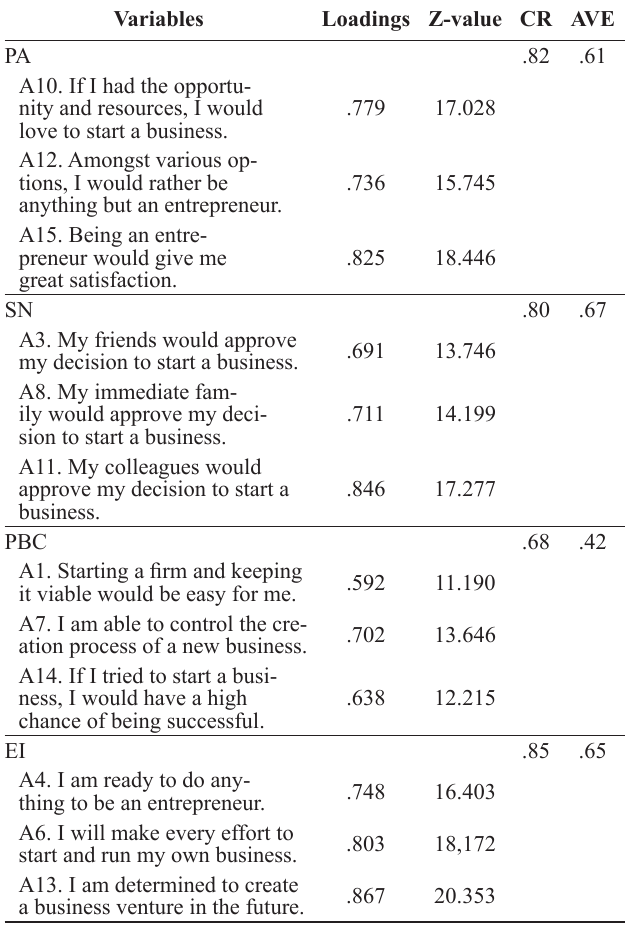
Table 1. Factor Loadings, Z-Values, Composite Reliability (CR), and Average Variance Extracted